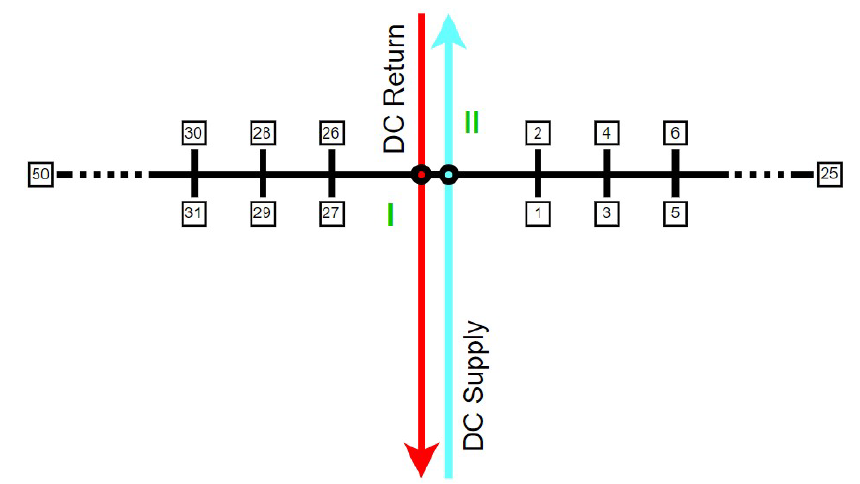
Figure 5. The setup for the district cooling supply and return lines for the office buildings.